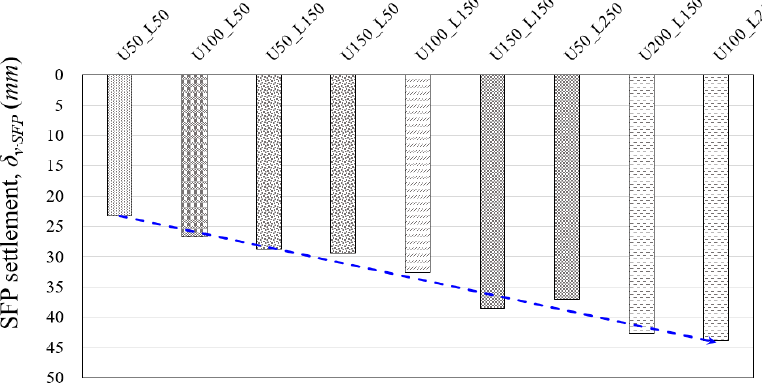
Figure 9. SFP settlement trend across the test